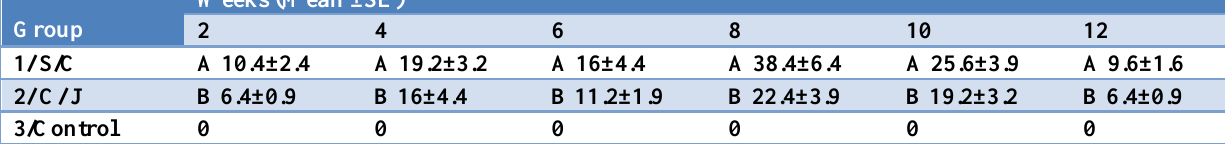
Table, 1: The mean of antibody titer of goats at 2, 4, 6, 8,10and12 weeks post-vaccination with RB51.